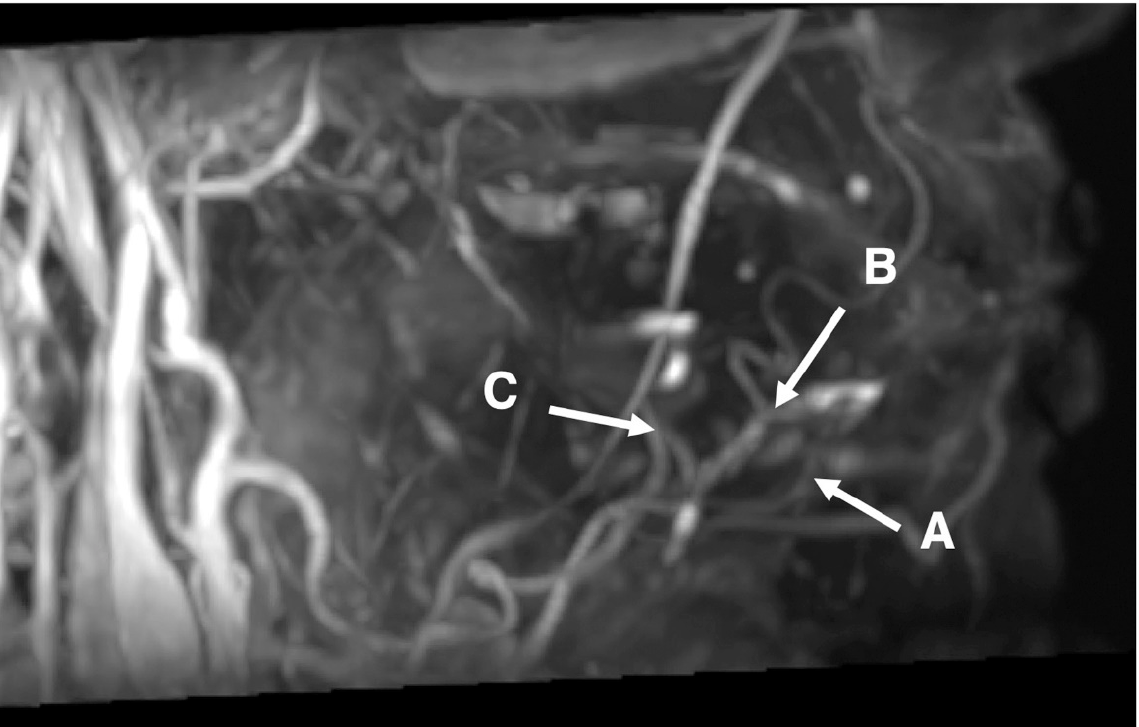
Figure 1. Image of 46-year-old male with left tongue carcinoma. Representative images of the submental, sublingual, and deep lingual arteries obtained by 3D MRA using SSFP with a time–SLIP. A: possible course of the submental artery around the area of the incisors; B: possible course of the sublingual artery around the incisors from premolar areas; and C: possible course of the deep lin- gual artery around the area of the molars.